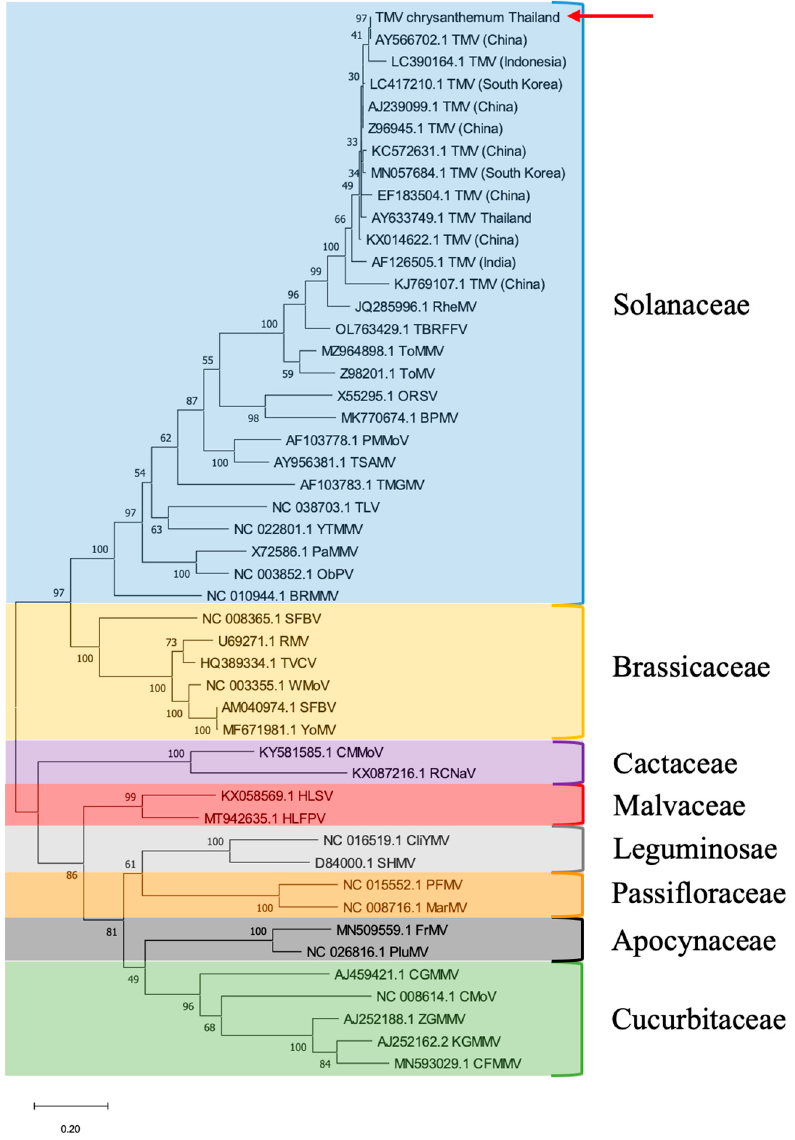
Figure 3. Phylogenetic tree analysis of TMV CP gene generated from 48 viral sequences comprising 13 TMV sequences and 35 tobamoviruses sequences. Thai chrysanthemum TMV is indicated by red arrow. Numbers at internal nodes indicate bootstrap percentages based on 1000 replicates. The scale bar indicates 0.2 substitutions per site. We compared the CP gene sequence of the Thai chrysanthemum TMV with those of other TMV isolates and members of the genus Tobamovirus.